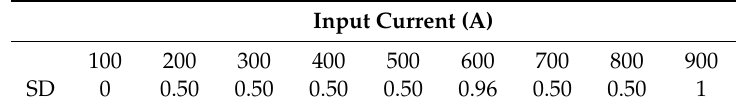
Table 3. Standard deviation results.